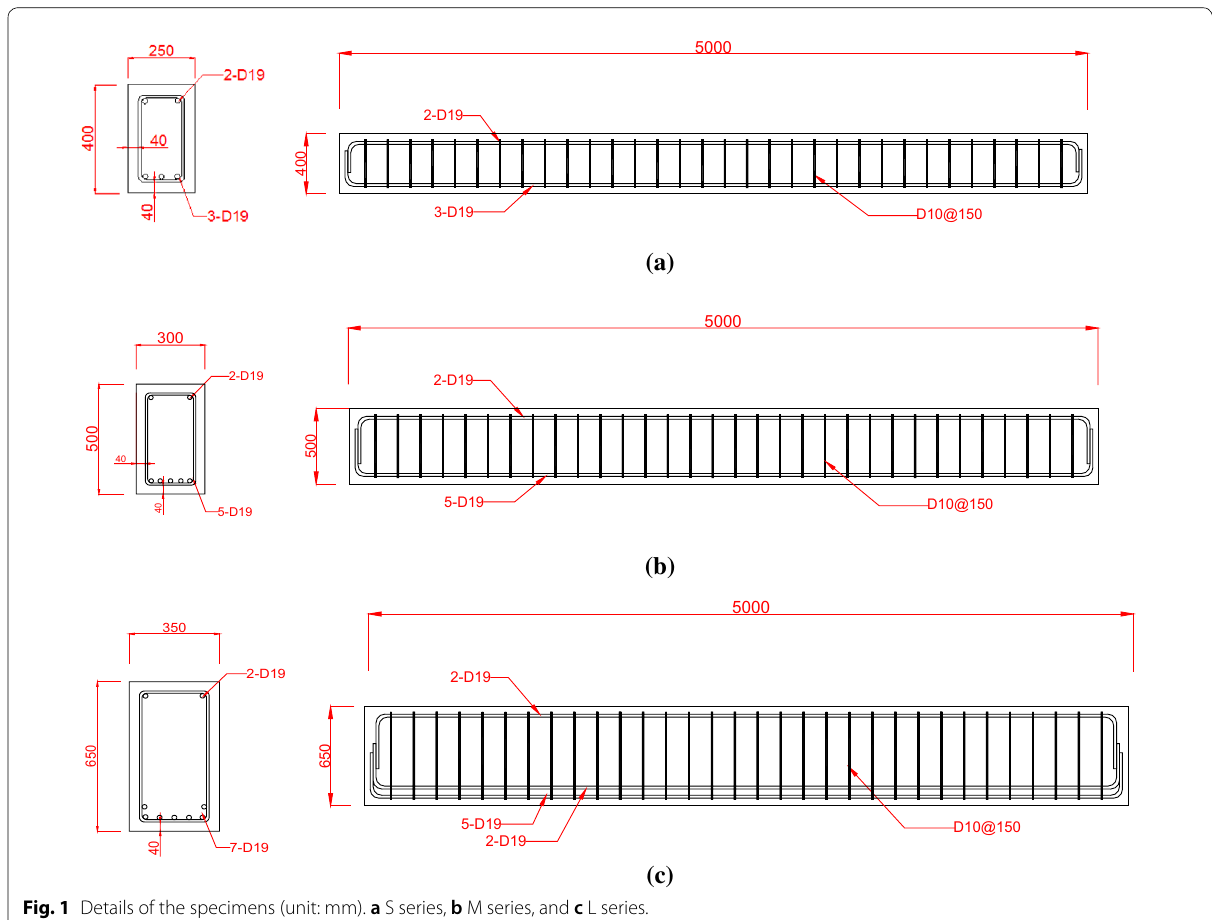
Fig. 1 Details of the specimens (unit: mm). a S series, b M series, and c L series. Table 2 material properties and mixture ratio for concrete. 28-day compressive strength (MPa)